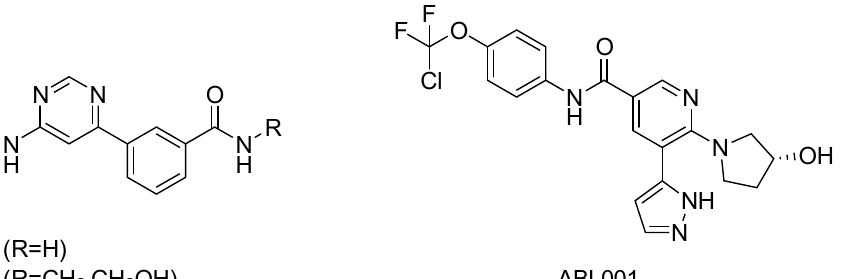
Figure 6. Bcr-Abl allosteric inhibitors.